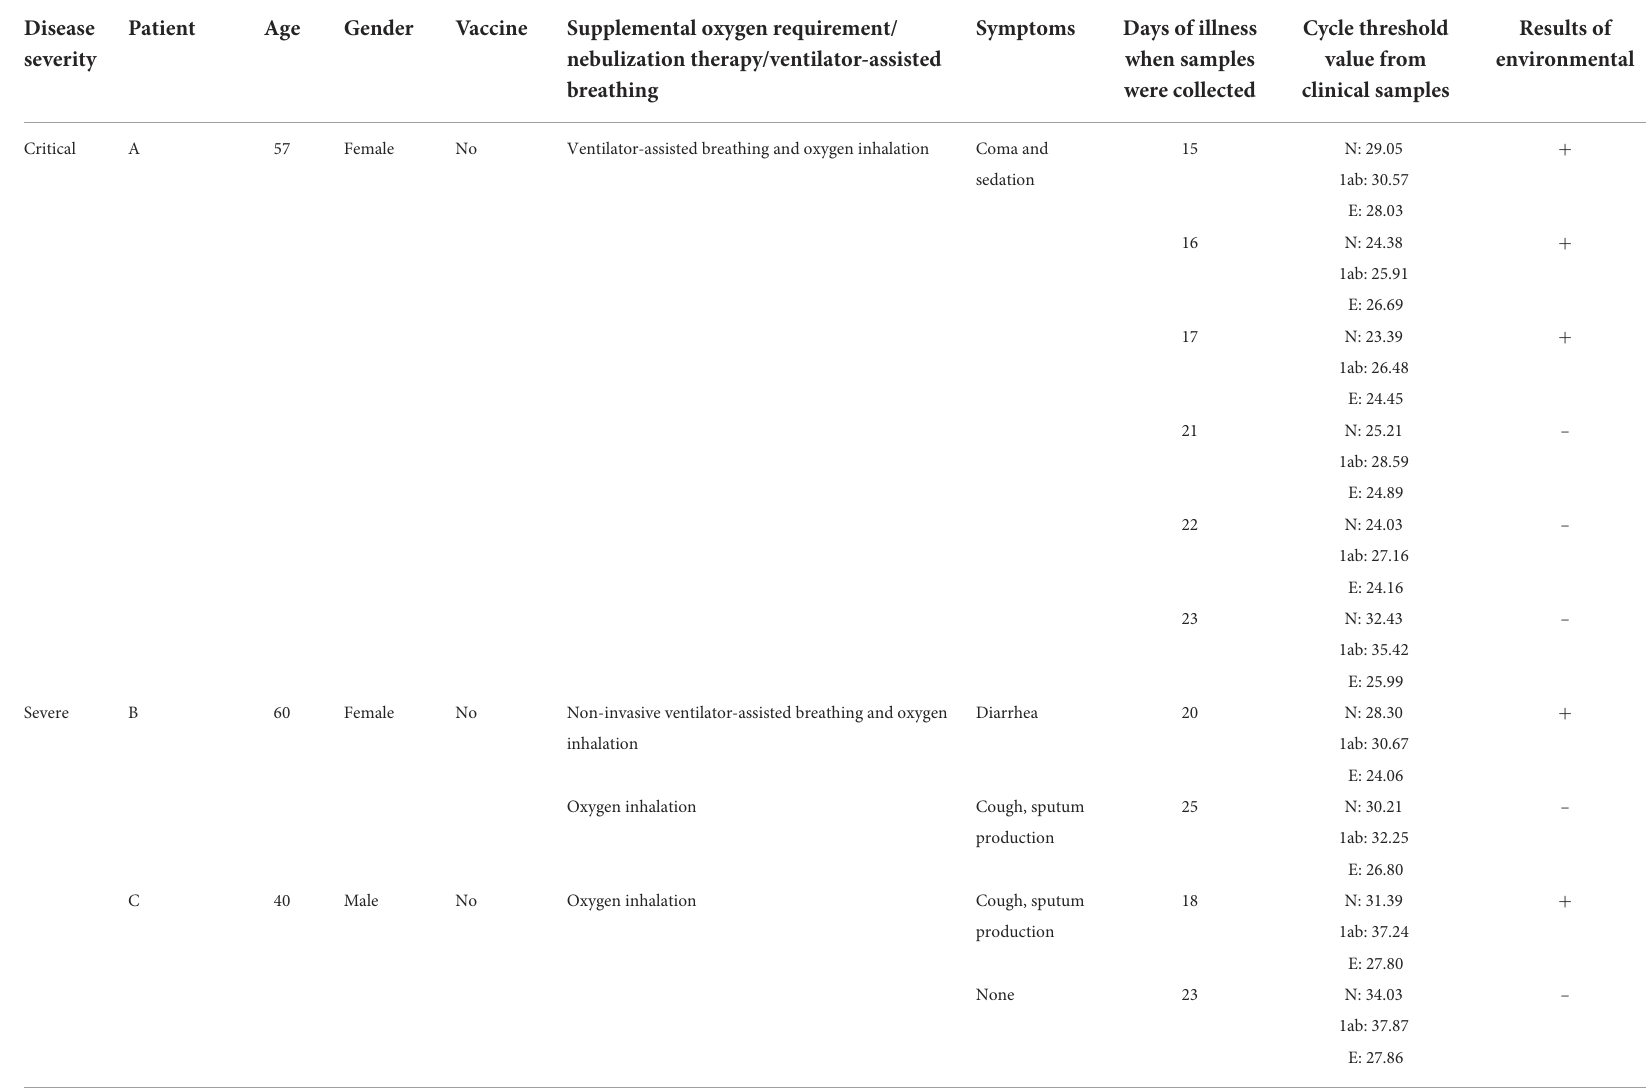
TABLE 1 Characteristics of